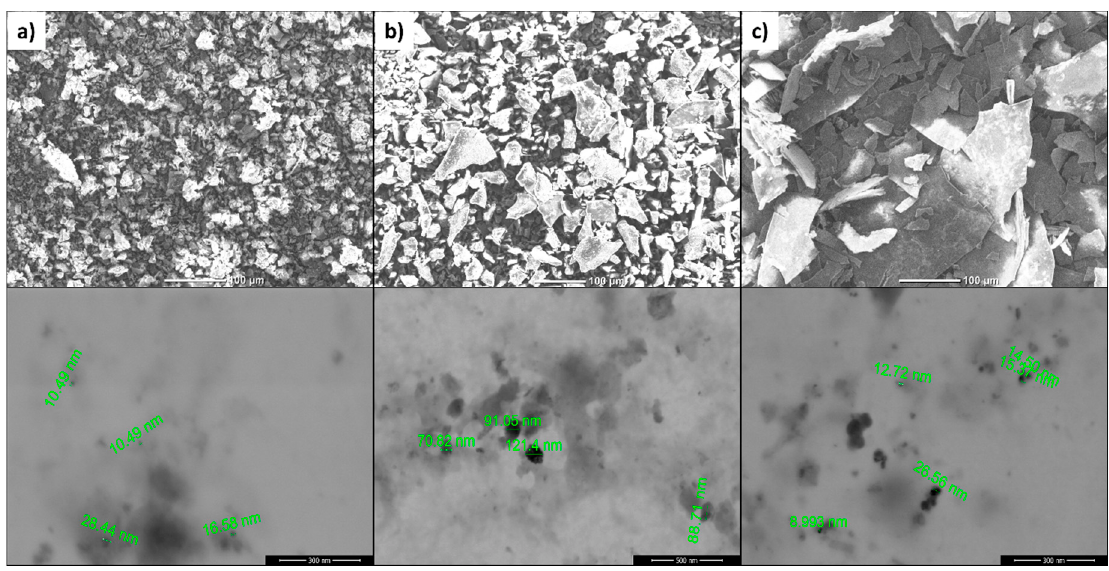
Figure 3. SEM ( up ) and FESEM ( down ) images of CuNP/CPE composites with different amounts of CPE: ( a ) 5 mg, ( b ) 15 mg, and ( c ) 30 mg.